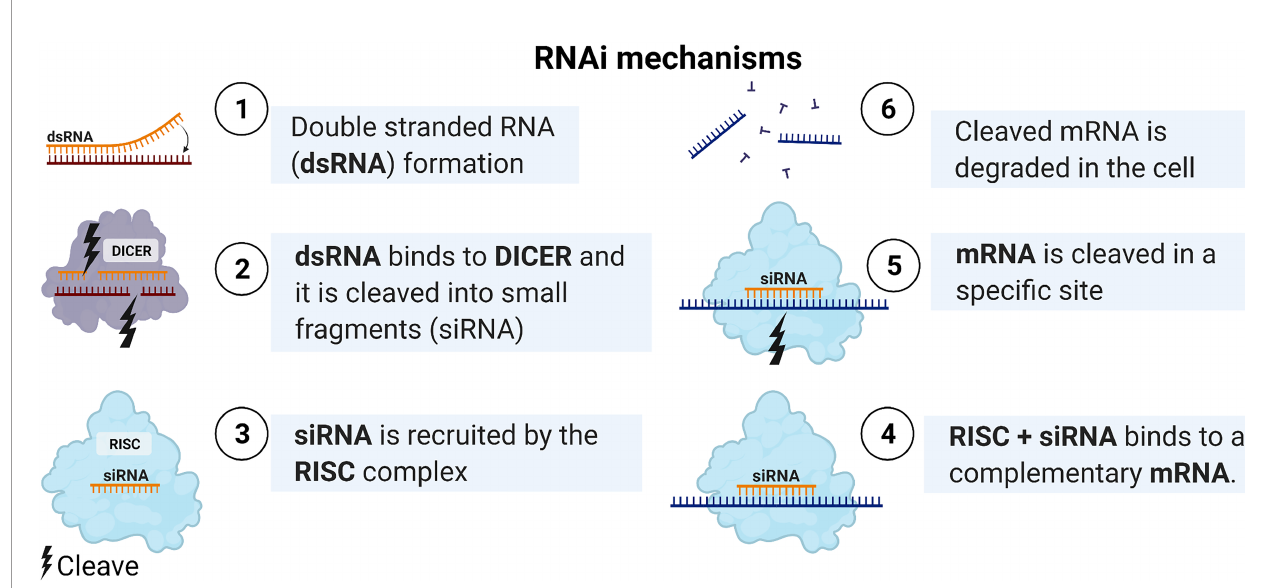
FIGURE 3 | RNAi mechanisms. After transfecting the double strand RNA, it is cleaved by DICER to form a smaller double-stranded miRNA. Then loaded as a guide for the miRNA-induced silencing complex (miRISC) to target the mRNA. Created with